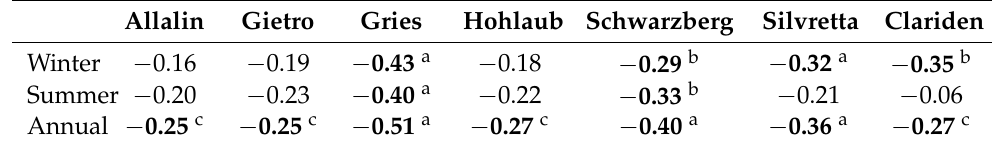
Table 6. Correlation coefficients of summer, winter, and annual air temperature versus Ba. Super- scripts a–c indicate significance at p < 0.01, 0.05, and 0.10, respectively.